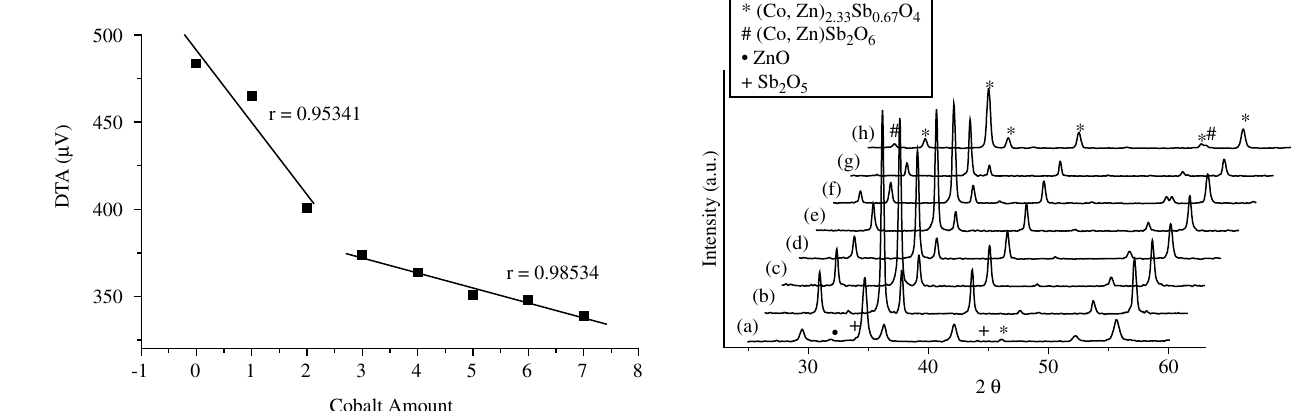
Figure 5. XRD after calcination at 1000 °C: a) Zn c)